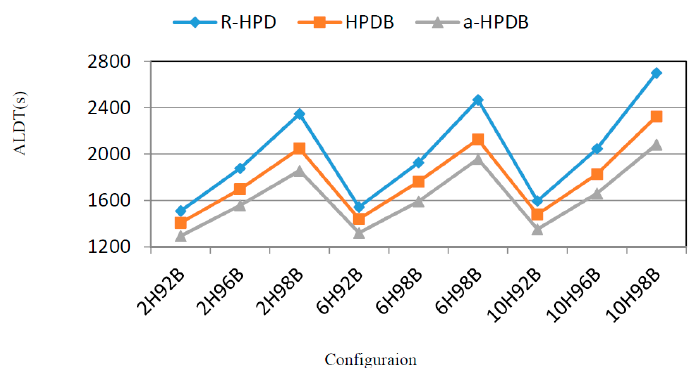
Figure 15. Simulation results of normal lots at different configurations.